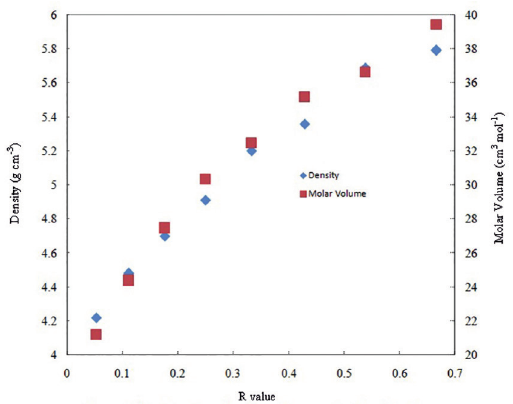
Figure 1: Plot of density and molar volume as a function of R value.